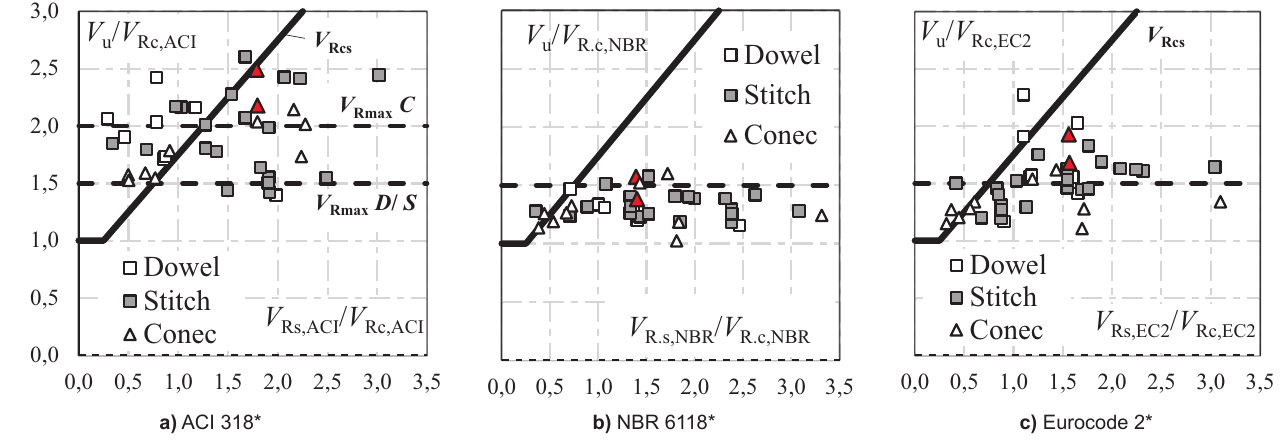
Desempenho das diferentes técnicas de reforço segundo as metodologias